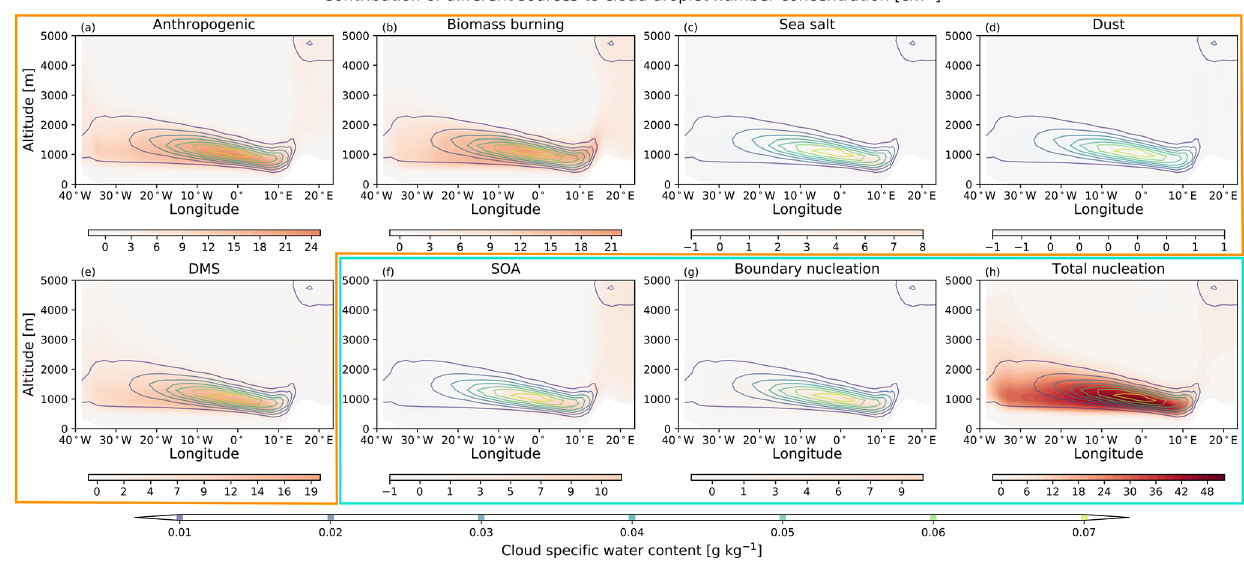
Figure 7. UKESM1-simulated annual mean vertical profiles of the cloud droplet number concentration (CDNC) from different sources. Profiles are averaged along the latitudes of the cloud box. The contributions of different sources to CDNC are listed in subplots (a) to (h) , where the contribution of emissions is shown using the orange frame, and the contribution of atmospheric processes is shown using the teal frame. The contour lines in each subplot are the cloud specific water content from the baseline simulation at the same temporal and spatial average. The same colour map scale is used in each subplot to facilitate comparison, but the range differs in each plot, corresponding to the maximum and minimum of the CDNC.